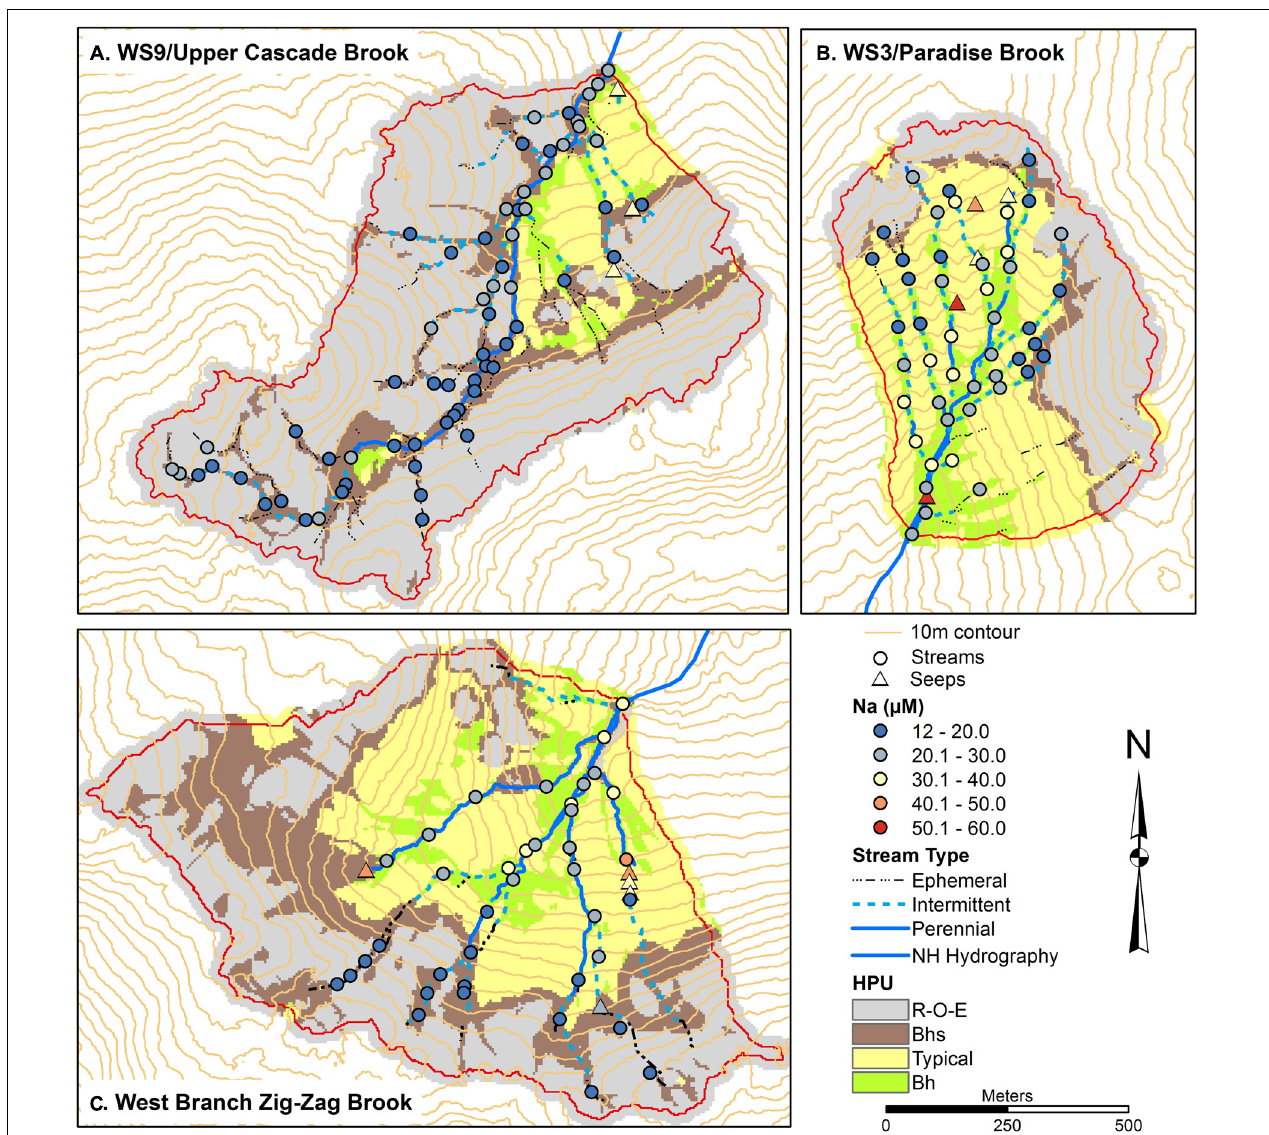
FIGURE 6 | Soils maps for W9 (A) , W3 (B) , and West Branch Zig Zag Brook (C) with variation in surface water sodium (Na) concentrations from a synoptic survey conducted July 22–23, 2015. Surface water samples were classified as streams (circles) or seeps (triangles). Soil units include bedrock outcrops, bedrock